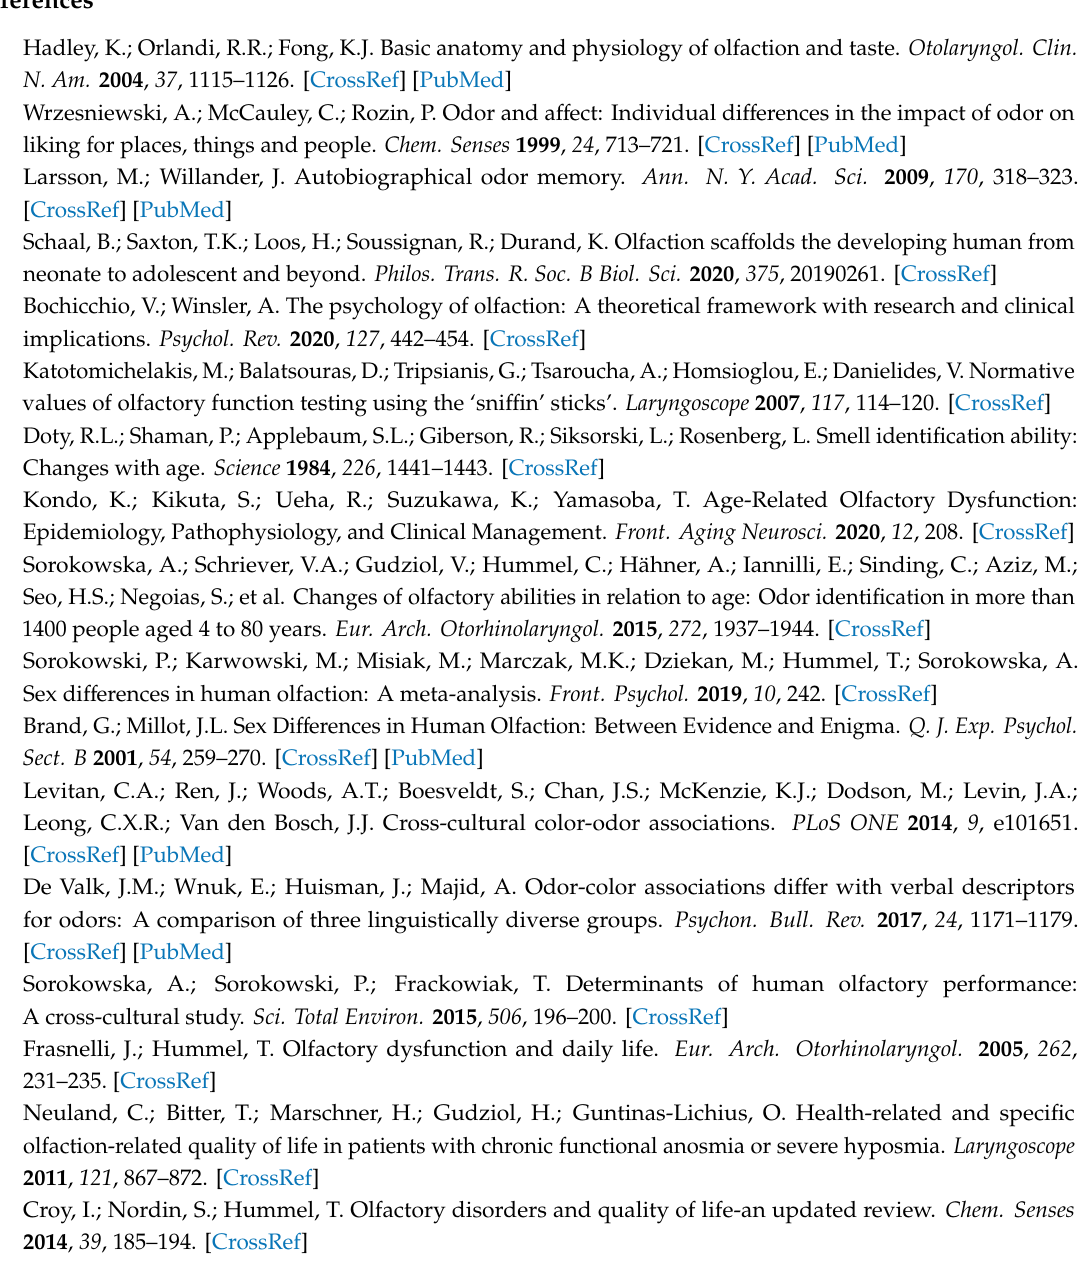
Table S1: Descriptive statistics of OT, OD, OI and TDI scores per Sex and